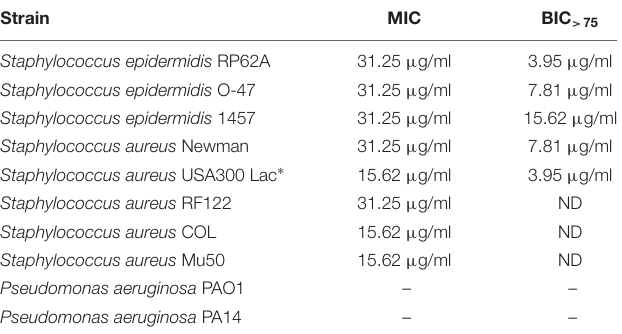
TABLE 2 | Effect of SKC3 on strains used in the